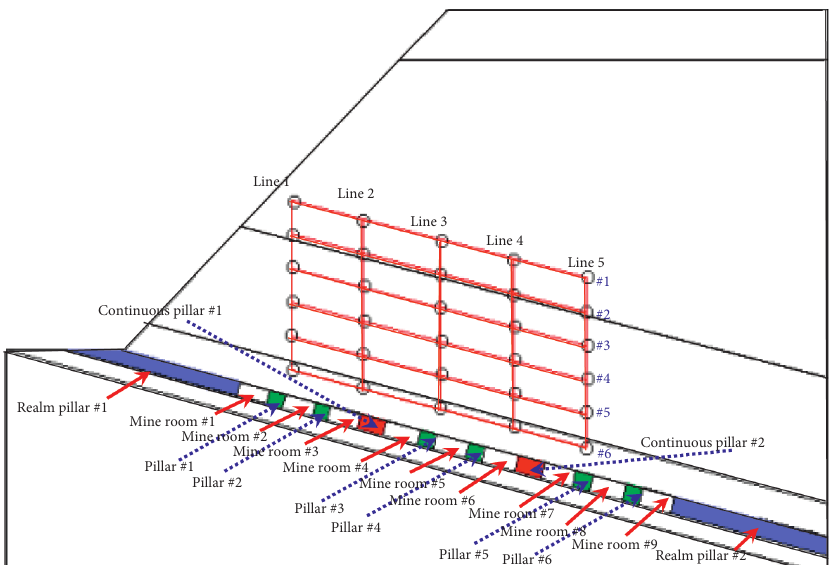
Figure 5: Displacement survey line monitoring diagram of a similar physical model.